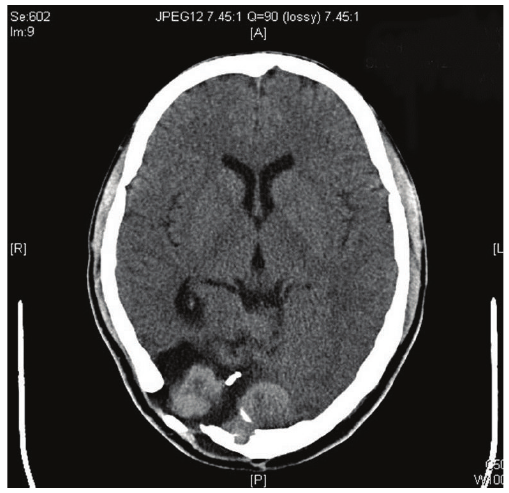
Figure 1: MRI scan demonstrates the recurred tumor mostly involved right posterior fossa.